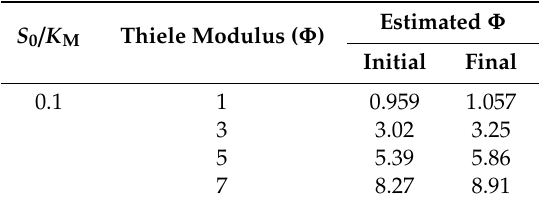
Table 6. Estimated Thiele moduli from the ratios of specific productivities at the initial and final stages of the hydrolysis of PenG by PGA at 30 ◦ C and pH